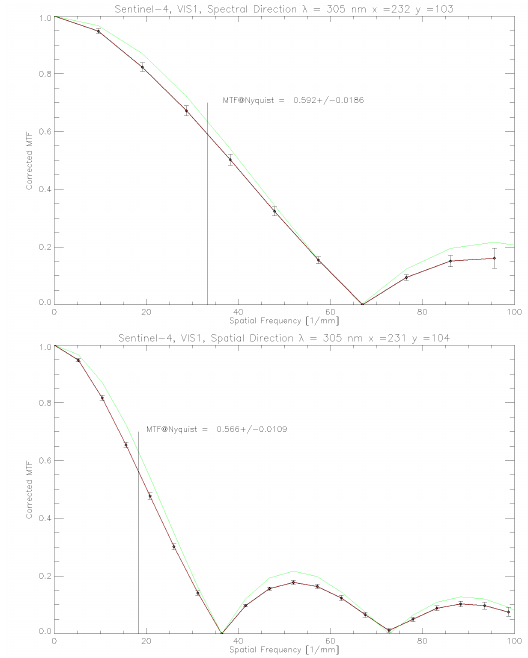
Figure 13. MTF (at 305 nm ) in spectral (upper image, 15 µm ) and spatial direction (lower image 27 . 5 µm )